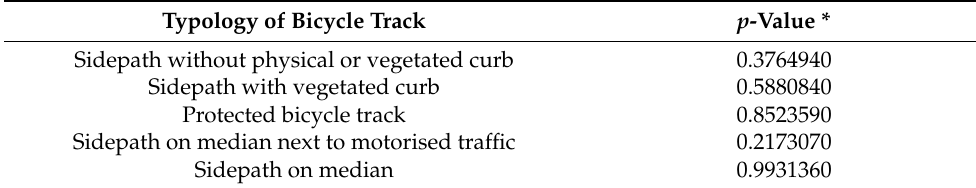
Table 6. Results of the Kruskal–Wallis test in intragroup analysis.